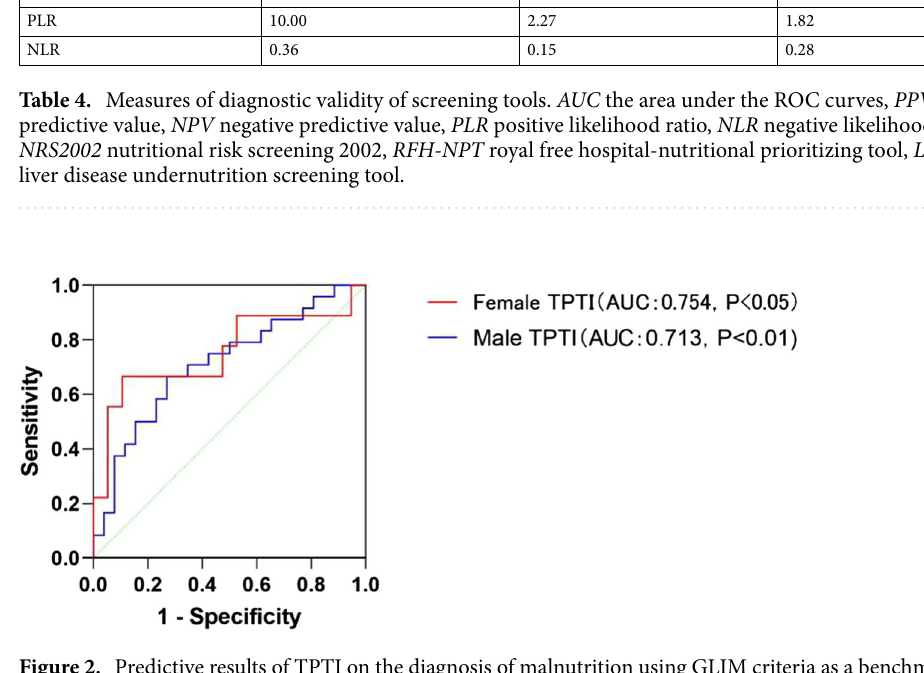
Figure 2. Predictive results of TPTI on the diagnosis of malnutrition using GLIM criteria as a benchmark.